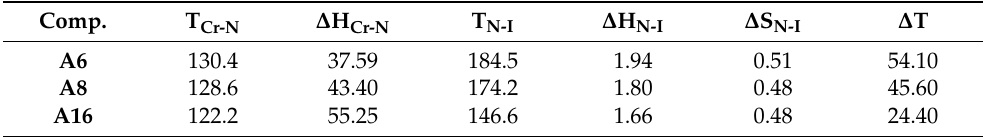
Table 1. Phase transition temperatures ( T ◦ C), enthalpy of transition, ∆ H, kJ/mol, normalized entropy, ∆ S , and mesophase temperature range, ∆ T , for groups An .